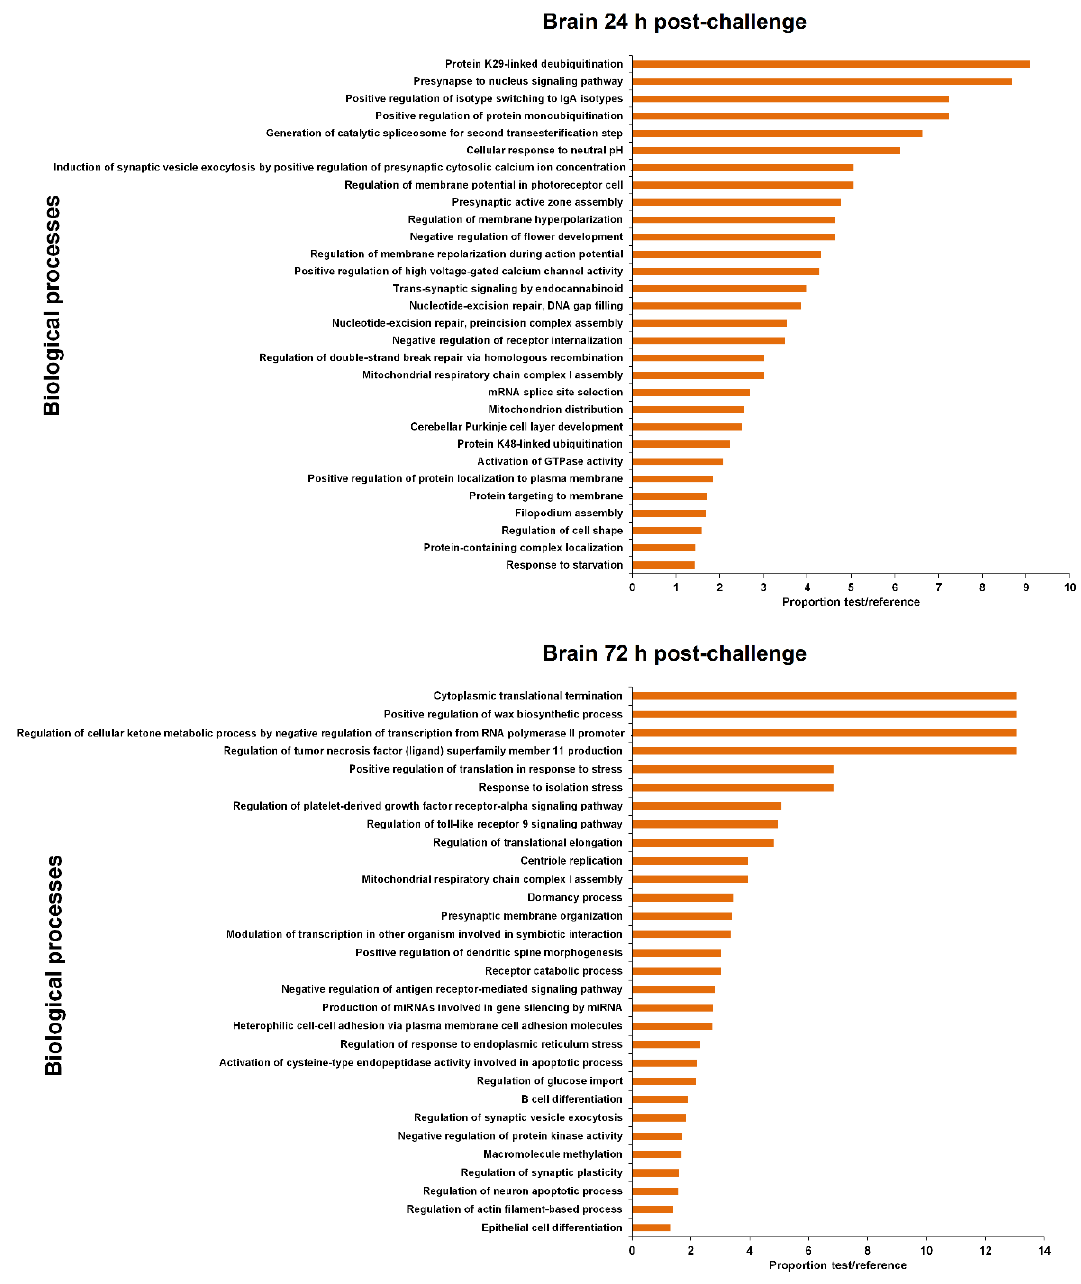
Figure 6. GO enrichment analysis (biological processes) of the neighbouring coding genes of the differentially modulated lncRNAs (FC > 2, FDR < 0.05) in the brain after viral challenge. Only the 30 most significant terms were represented.